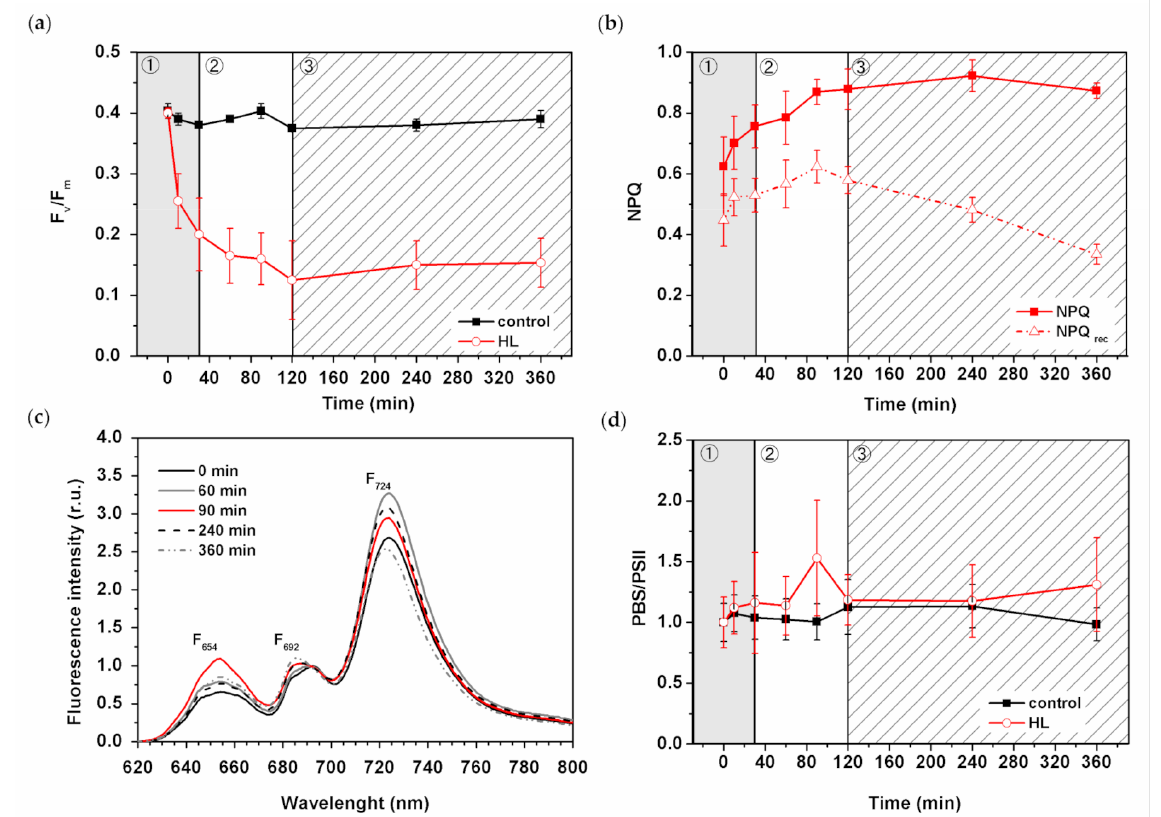
Figure 4. Effect of HL stress on photoprotective mechanism in Synechocystis PSI-YFP cells. ( a ) Change in maximal quantum yield of PSII (Fv/Fm) due to photoinhibition in cell suspension. Black/red lines represent control/HL treated sample; n = 3. ( b ) Extent of blue light-induced non-photochemical quenching on light (NPQ—squares) and its recovery in dark (NPQrec—triangles) during HL stress; n = 4. ( c ) Typical curve of low temperature (77K) fluorescence emission spectra (excitation 530 nm) for cells exposed to HL for different times (0 min—straight black line; 60 min—straight grey line; 90 min—red line; 240 min—dashed black line; 360 min—dashed grey line). F654, F724, F724 represent the positions of